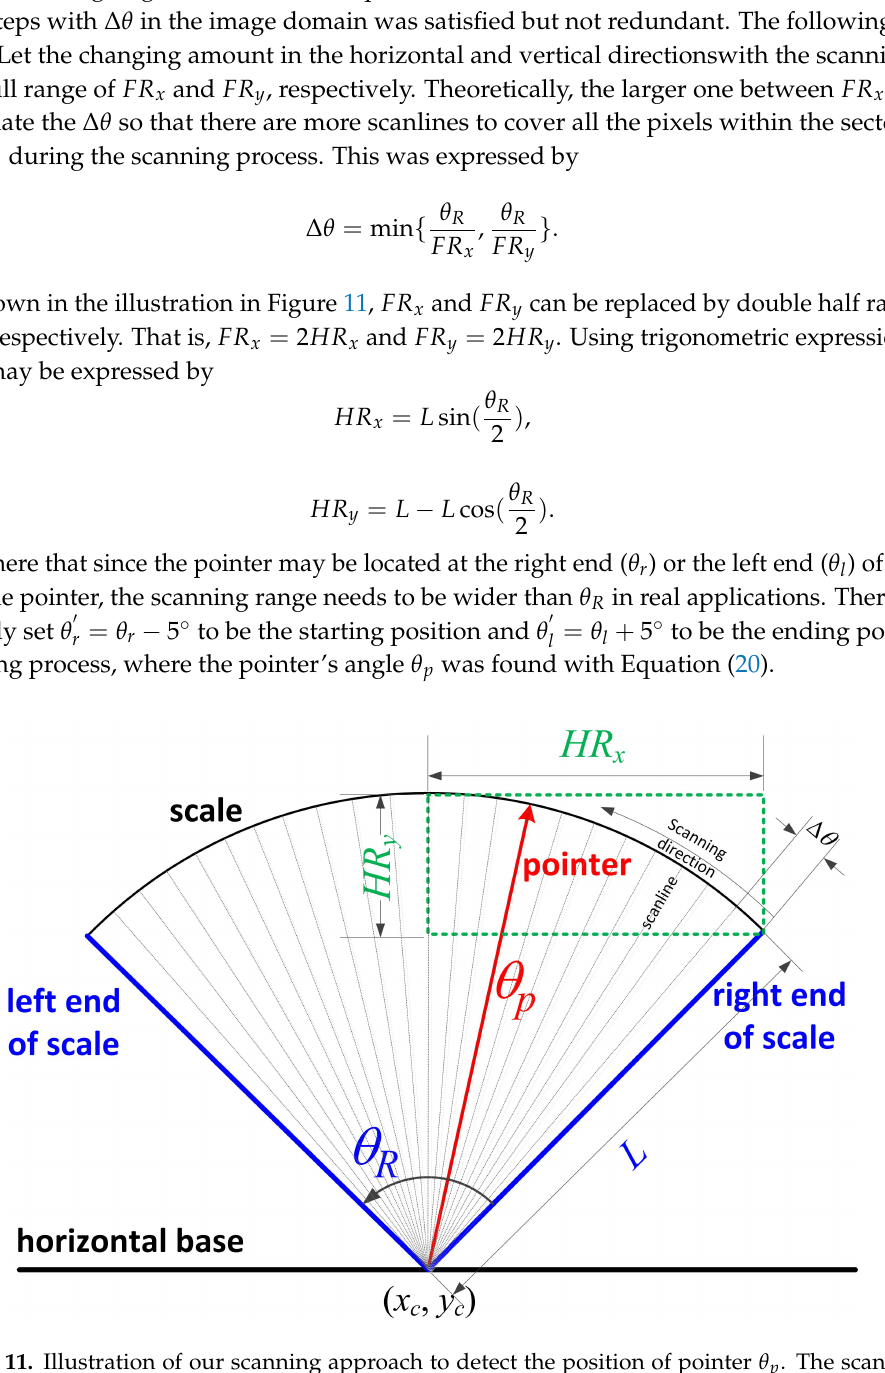
Figure 11. Illustration of our scanning approach to detect the position of pointer θ p . The scanning direction is from θ r to θ l , i.e., the range ( θ R ), to find θ p where the corresponding scanline indicates the largest gradient change with zero-crossing property in the profile of GA